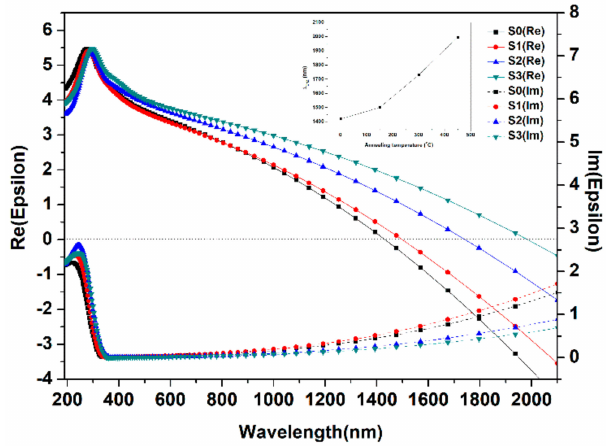
Figure 3. Real (solid line) and imaginary (dash line) part of permittivity of ITO films before and after annealing. The inset shows λ ENZ as a function of annealing